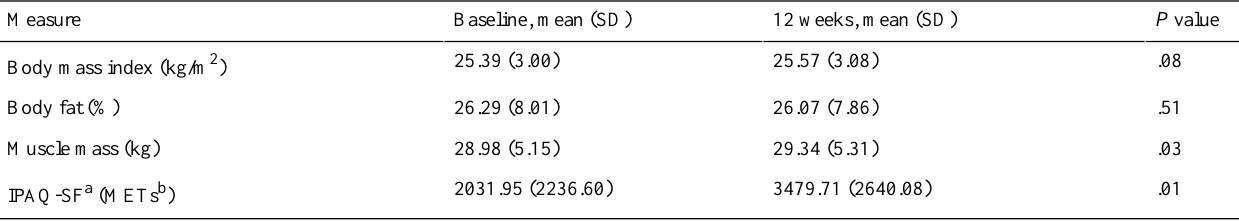
Table 3. Changes in body composition and self-reported physical activity.